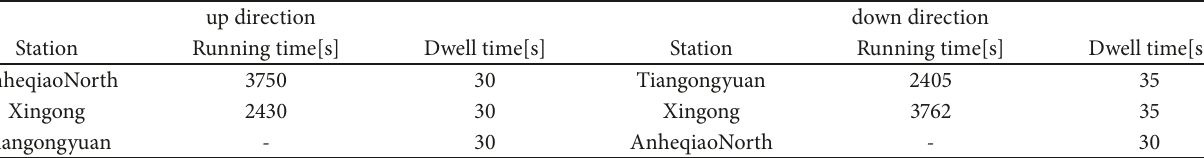
Table 4: Operation information of line 4 in Beijing.